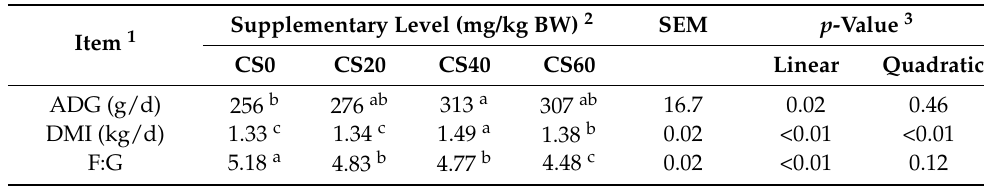
Table 2. Effect of dietary cysteamine (CS) addition on growth performance and feed efficiency of feedlot lambs.